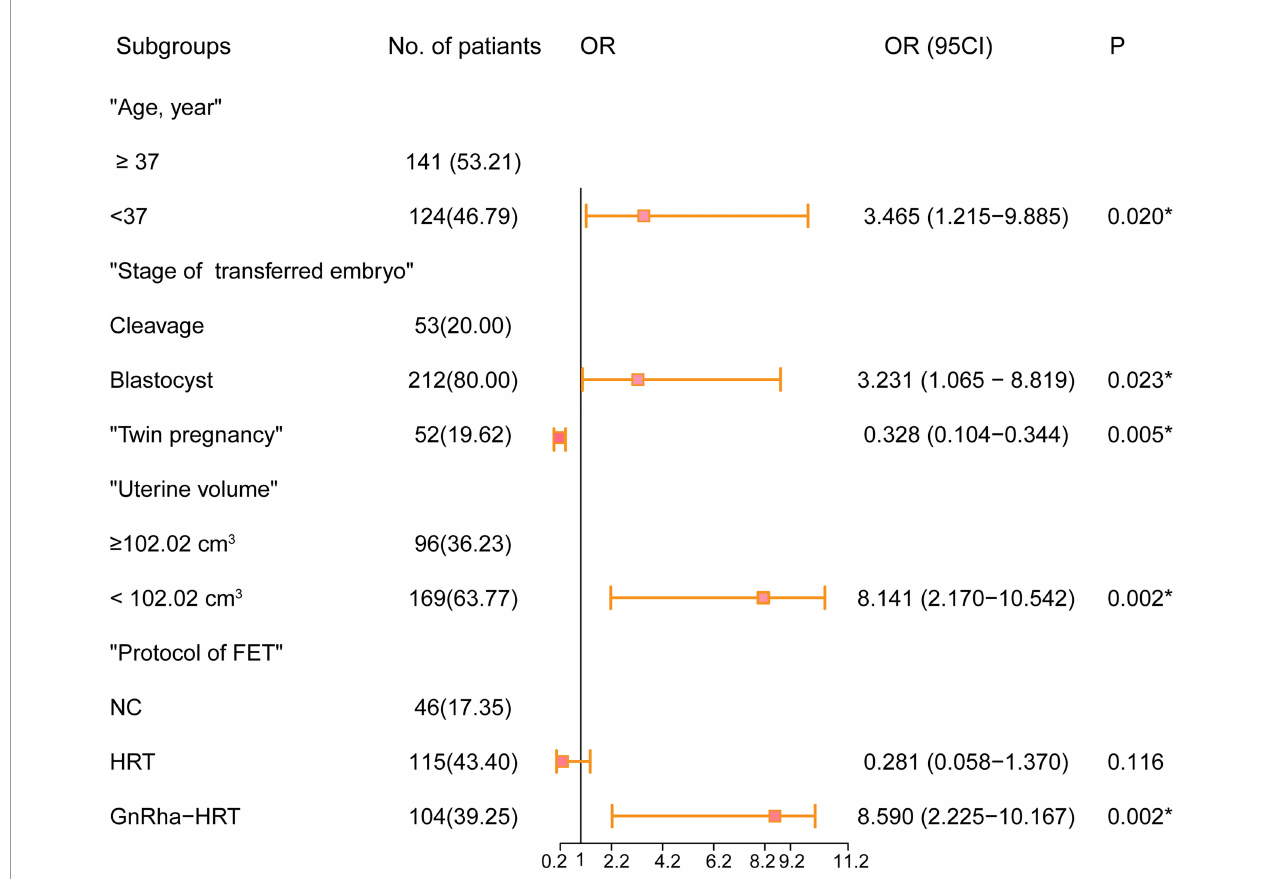
FIGURE 1 | Forest plot of the predictive factors of live birth in the multivariable analysis of the training cohort. OR and 95% CI are presented to show the risk of predictive factors. FET, frozen – thawed embryo transfer; OR, odds ratio; CI, con fi dence interval. * P < 0.05 was considered statistically signi fi